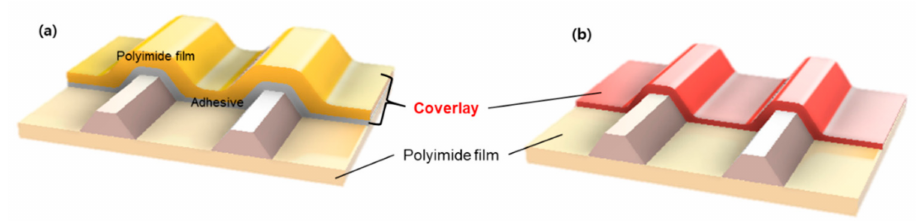
Figure 1. Schematics of the FPCB structure containing ( a ) conventional coverlay ( b ) this work